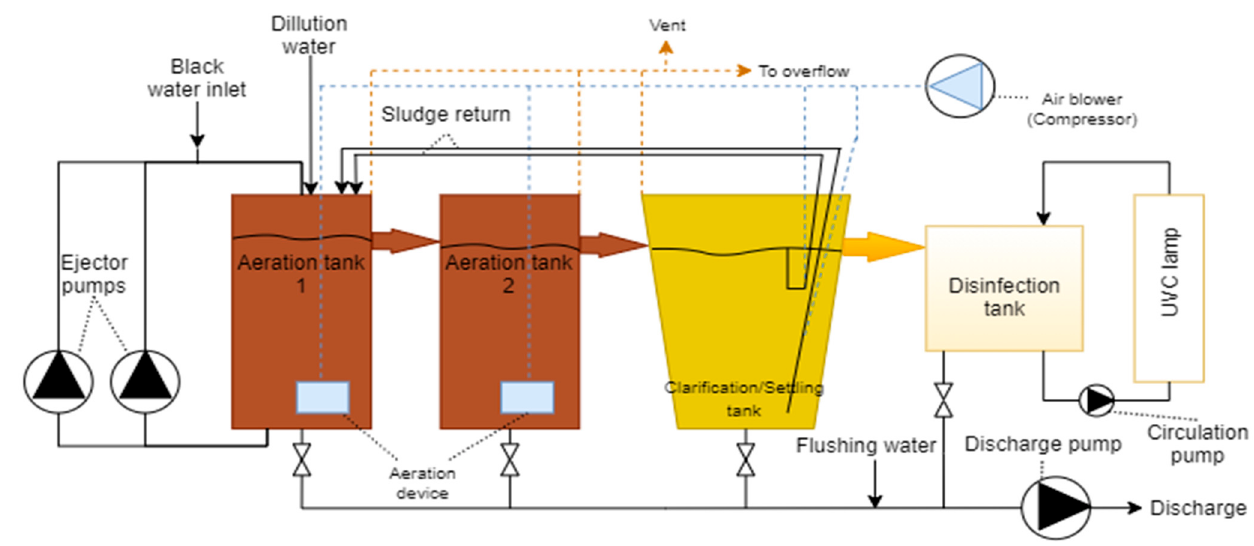
Figure 8. Main components and principle of operation of the biological sewage treatment plant.